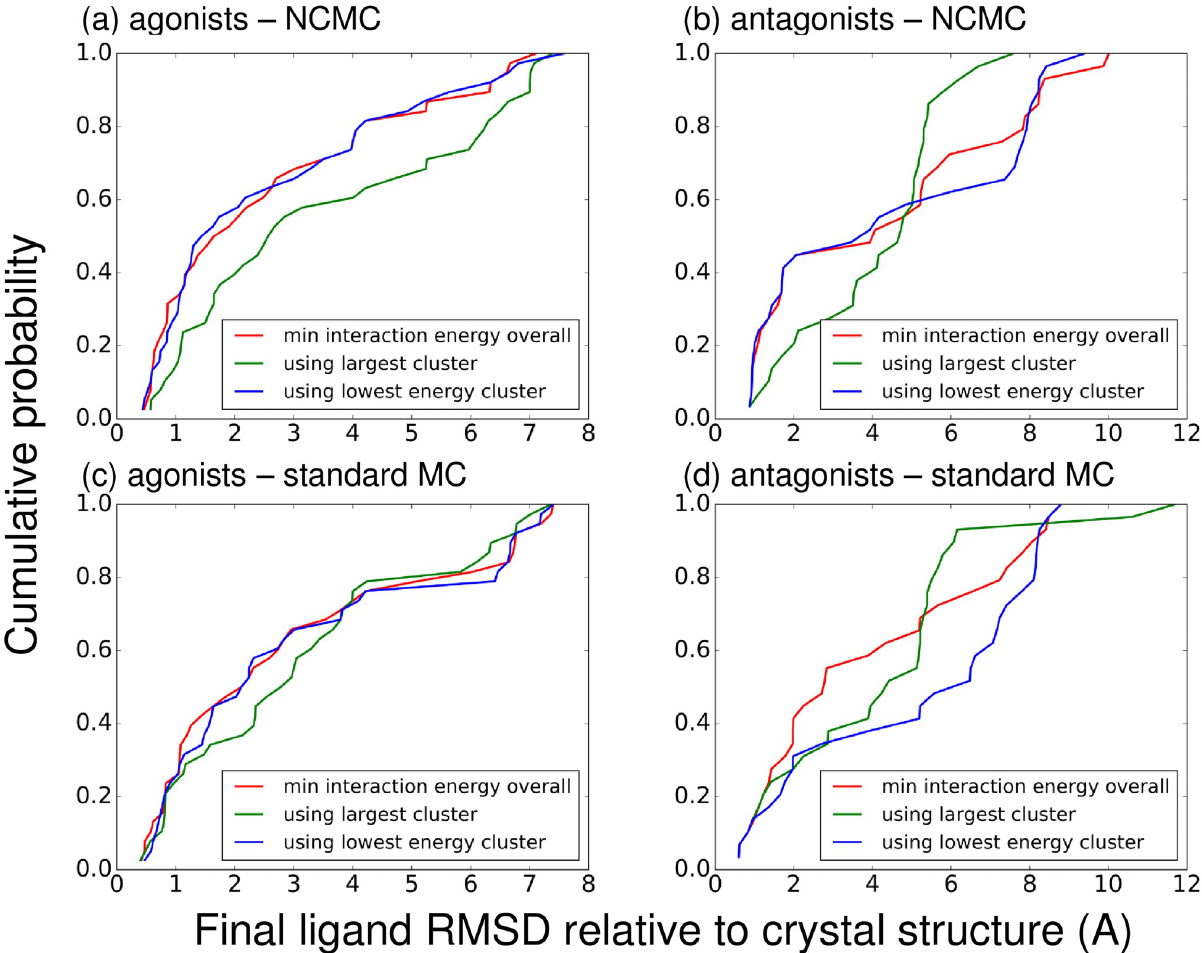
Fig 9. Comparison of methods for ranking ligands. Each graph shows the cumulative distribution of the RMSD of the best conformation (chosen by the indicated method) for (a)-(b) simulations using NCMC or (c)-(d) simulations using standard MC, with a fully flexible protein. (a) and (c) compare ligand-ranking methods for agonists; (b) and (d) do so for